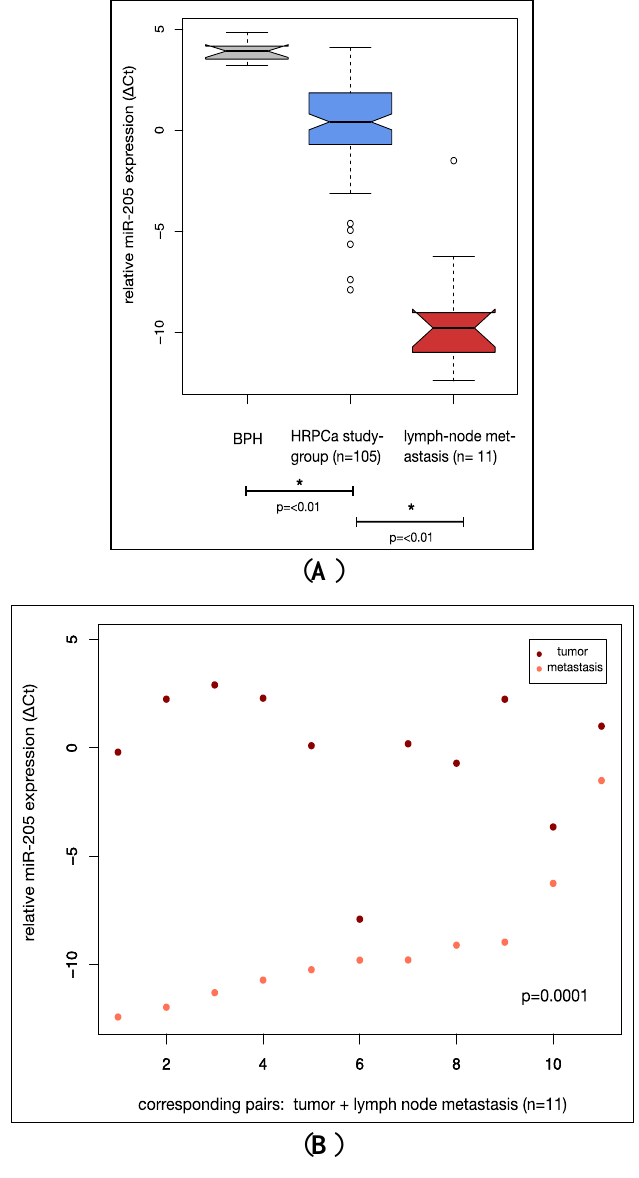
Figure 2. Increasing down-regulation of miR-205 expression in a HRPCa cohort ( n = 105) and lymph node metastases. Relative miR-205 expression was analysed by the Δ C t method using qRT-PCR in all samples. ( A ) MiR-205 expression was analysed in 10 BPH tissues ( left box ), 105 HRPCa specimen ( middle box ) and 11 lymph node metastases ( right box ). Significant reductions in expression levels are marked by * ( p <0.01). p -values were calculated using one-way ANOVA with post hoc testing (Tukey’s test); ( B ) Dot plot of miR-205 expression in synchronous lymph node metastasis. 11 pairs of primary tumour samples and corresponding lymph node metastases were analysed. p -value was calculated by Student’s paired t